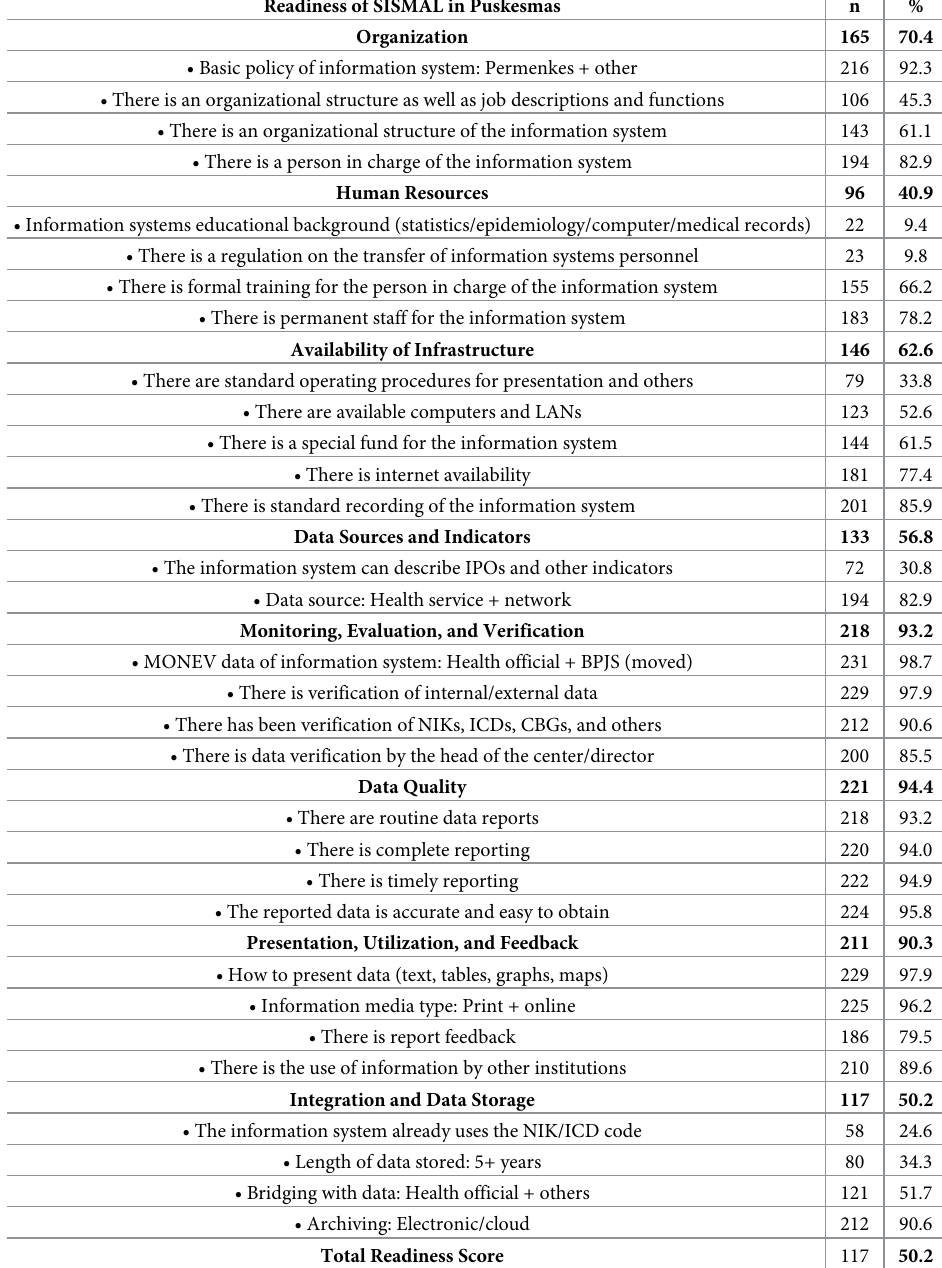
Table 2. Readiness of malaria surveillance information systems at primary health centers (n =